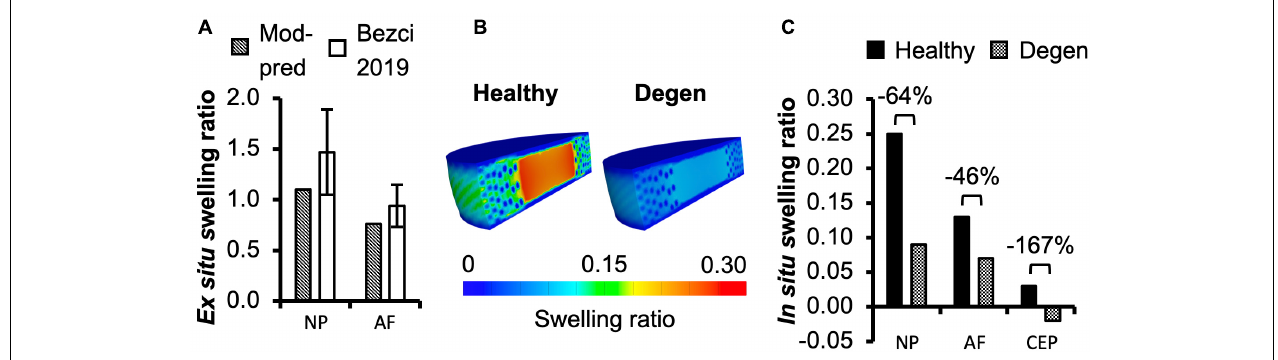
FIGURE 4 | (A) Model-predicted (Mod-pred) ex situ swelling ratios of the nucleus pulposus (NP) and the inner-middle annulus fibrosus (AF) compared to experimental (EXP) data reported by Bezci et al. (2019). (B,C) Model-predicted in situ swelling ratios of the NP, AF, and cartilage endplate (CEP) in healthy and degenerated (Degen) disc models. Relative changes in in situ swelling ratio with degeneration are labeled above corresponding neighboring bars.